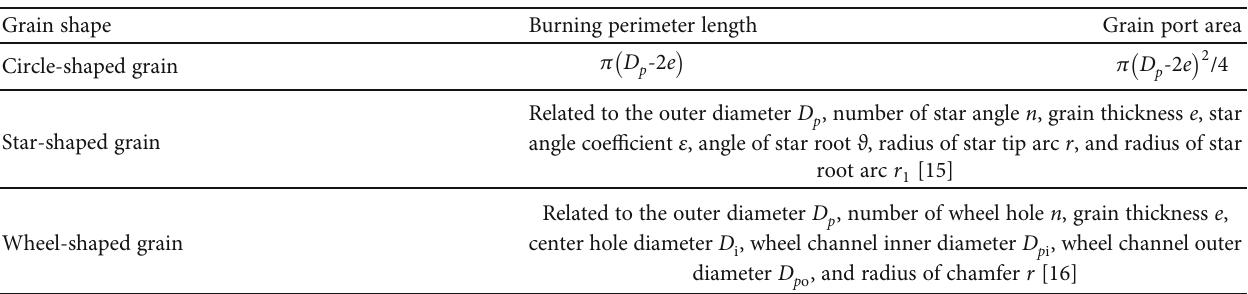
Table 1: De fi nition of initial grain shape